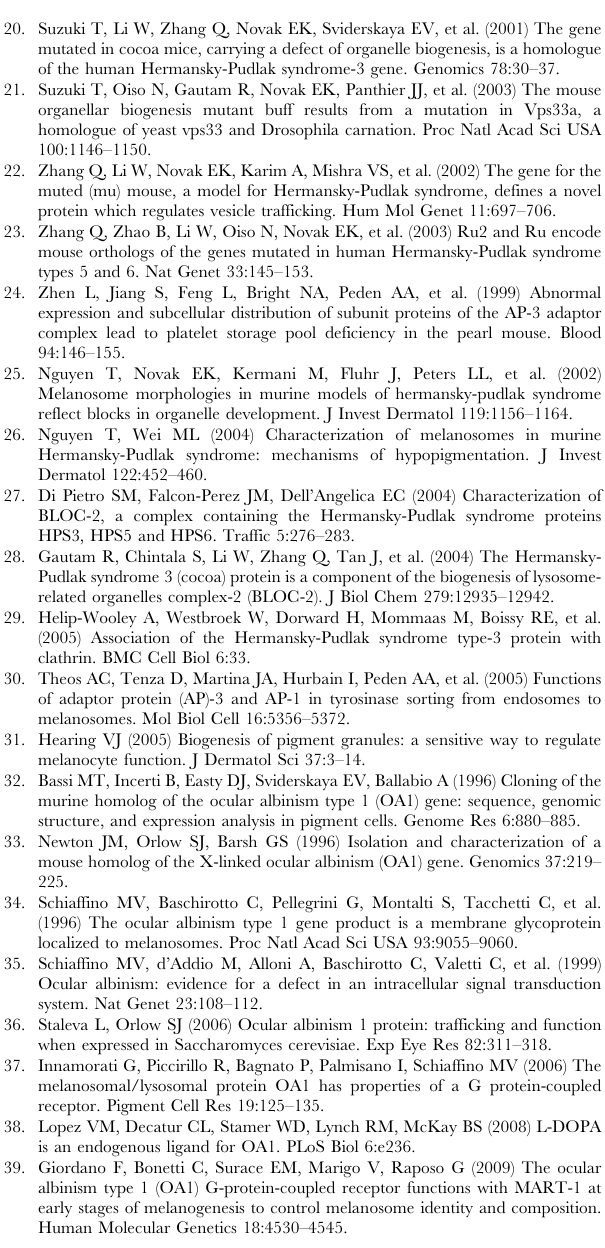
Figure S1 Melanoregulin loss of function or overexpres- sion have little effect on the size distribution of melanosomes in either the RPE or choroid. Data quantitated as shown in Figures 3D and 5D. The shape of the curves is nearly identical in wildtype, melanoregulin loss of function, and in melanoregulin overexpression. Data shown are an average 6 SEM; differences are not statistically significant with p .